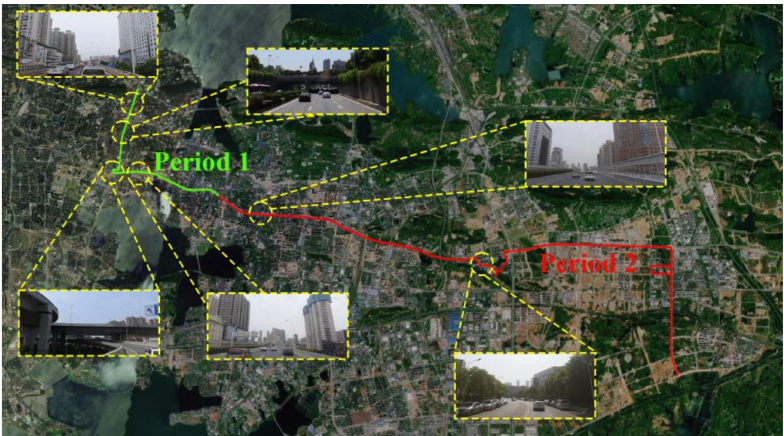
Figure 2. The trajectory of experiment